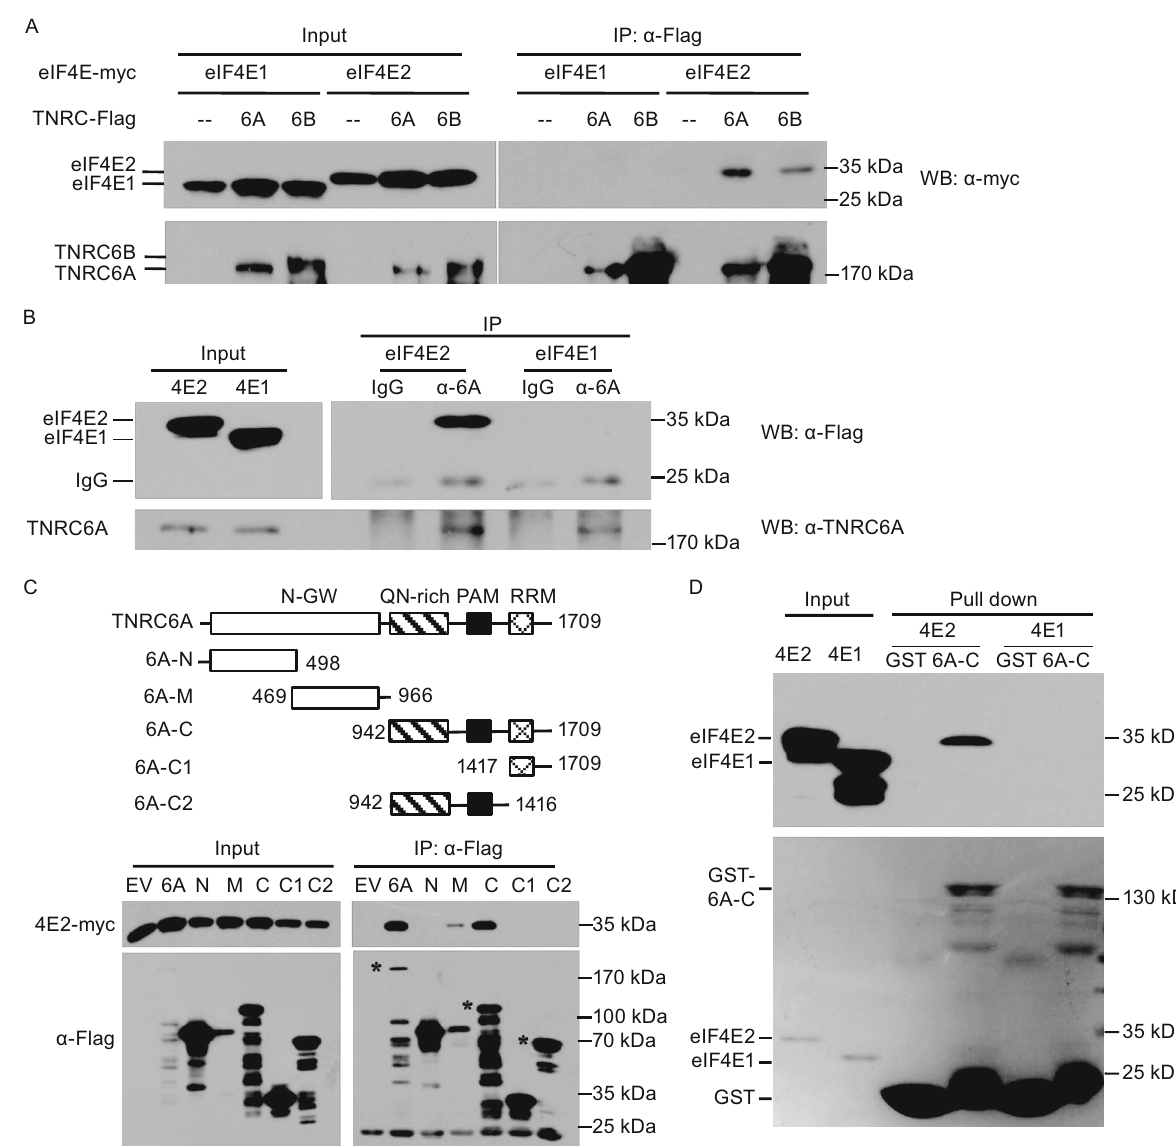
Figure 2. TNRC6A interacts with eIF4E2. (A) Plasmids expressing proteins indicated were transfected into HEK293Tcells. At 48 h posttransfection, cells were lysed and the lysates were immunoprecipitated (IP) in the presence of RNase A. The precipitates were resolved on SDS-PAGE followed by Western blotting. (B) A plasmid expressing Flag-tagged eIF4E1 or eIF4E2 was transfected into HEK293Tcells. At 48 h posttransfection, cells were lysed and the lysates were immunoprecipitated with the anti-TNRC6A antibody or control IgG in the presence of RNase A. The precipitates were resolved on SDS-PAGE followed by Western blotting. (C) Upper: schematic representation of TNRC6A truncation mutants. Lower: A plasmid expressing the TNRC6A mutant indicated and a plasmid expressing myc-tagged eIF4E2 were transiently transfected into HEK293T cells. At 48 h posttransfection, cells were lysed and the lysates were immunoprecipitated with anti-Flag antibody in the presence of RNase A followed by Western blotting. (D) Bacterially expressed Flag-tagged eIF4E2 or eIF4E1 was incubated with Glutathione Sepharose 4B bound fusion protein of GST and the C-terminal domain of TNRC6A (6A-C). The precipitates were washed and resolved on SDS-PAGE followed by commassie brilliant blue staining (lower) and Western blotting